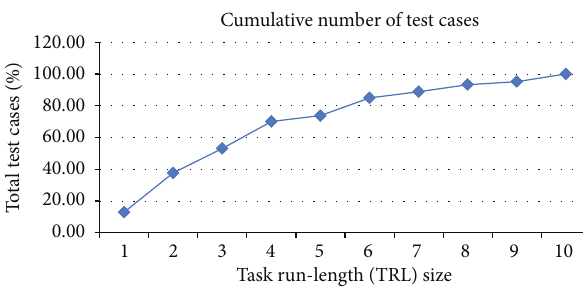
Figure 2: Cumulative graph of distribution of TRL size. number of columns disturbed to minimize the number of running tasks getting halted during reconfiguration. CLook method is explained in Trong